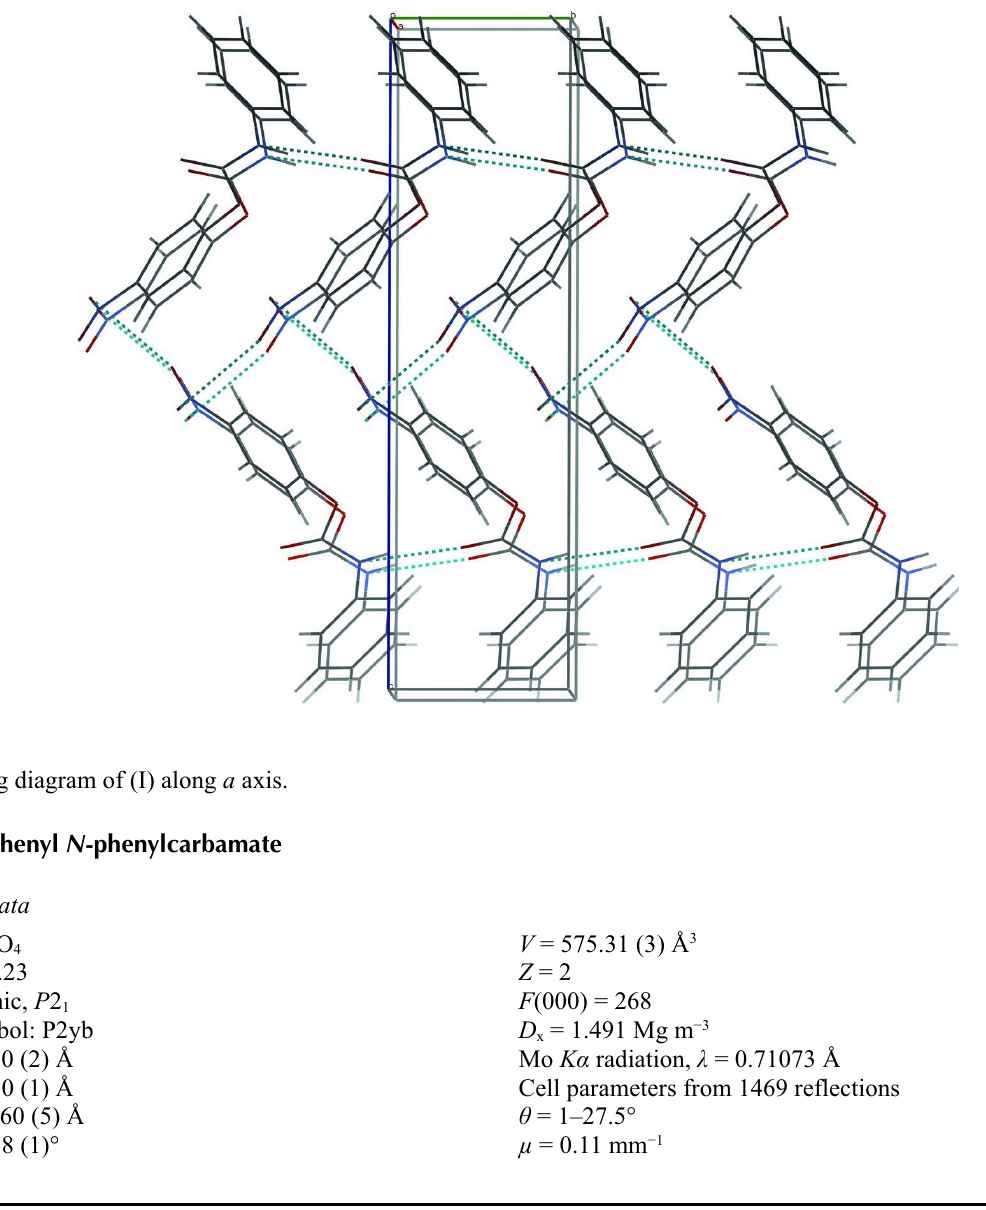
Figure 1 The molecular structure of (I), with displacement ellipsoids drawn at the 50% probability level (arbitrary spheres for the H atoms).